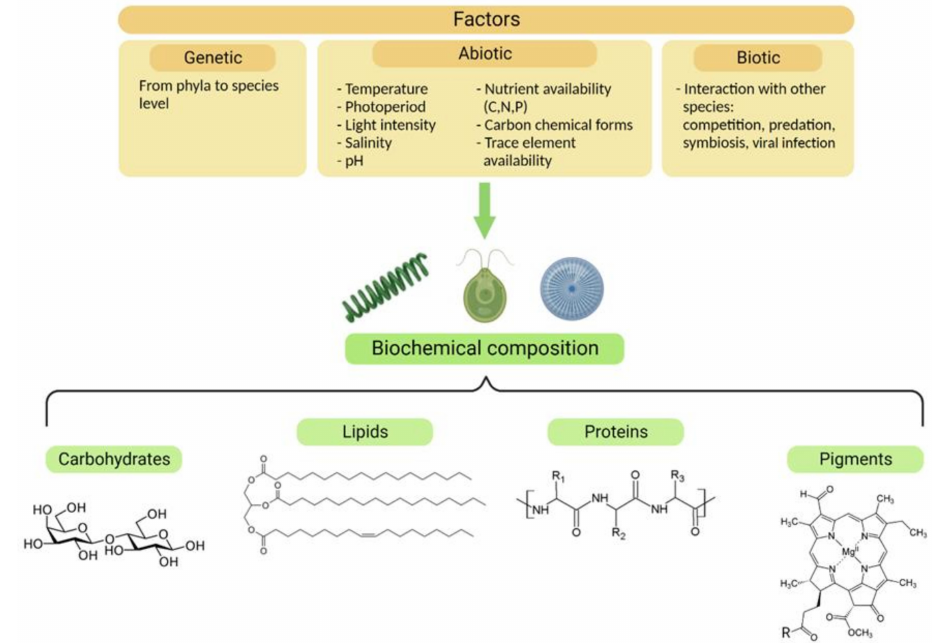
Figure 2. Factors influencing the biochemical composition of microalgae. Genetic, abiotic, and biotic factors can modify the concentrations and proportions of the four classes of molecules represented in the figure, which are desirable components for